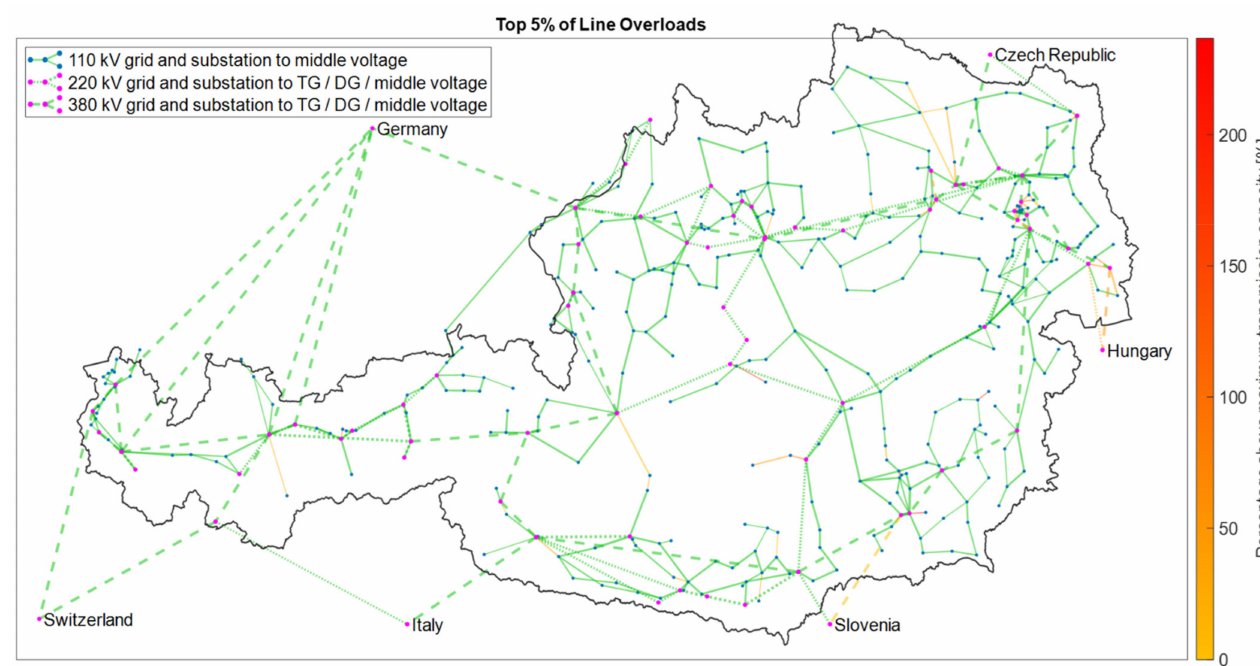
Figure 16. The top 5% line overloads of Austria’s power grid—Scenario 2.